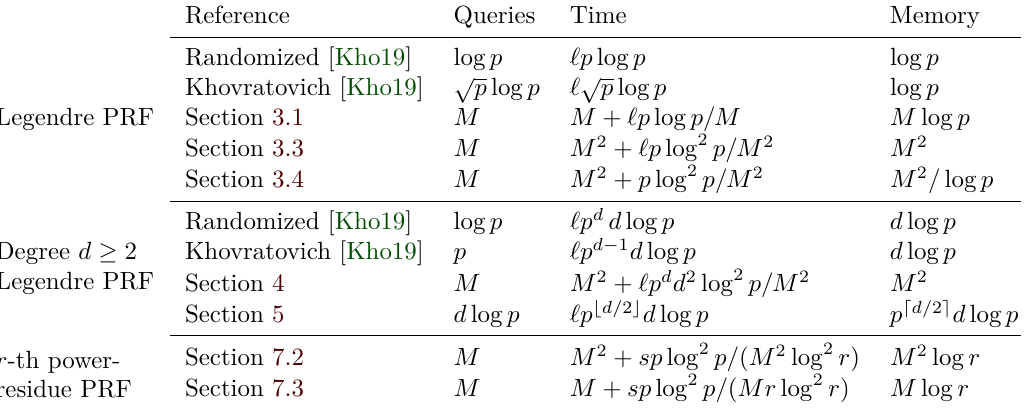
Table 1: Query, time and memory requirements of previous and new attacks on the Legendre PRF. The reported time and memory values are asymptotic upper bounds ( O -notation) and assume a machine with word size Θ(log p ), ‘ and s denote the time- complexity of computing a Legendre and power residue symbol respectively. The attack strategy for composite moduli from Section 6 can be combined with any of the attacks in this